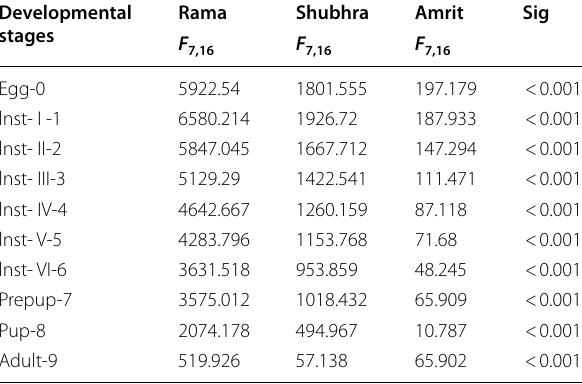
Table 5 ANOVA result of stage-specific pooled life table (Mean SE of 3 observations/cultivar) for the 9 cohorts ( n ± of S. obliqua Walkar neonates (instar I–VI) on the selected sesame ( S. indicum ) cultivars (Rama, Shubhra and Amrit) cultivated